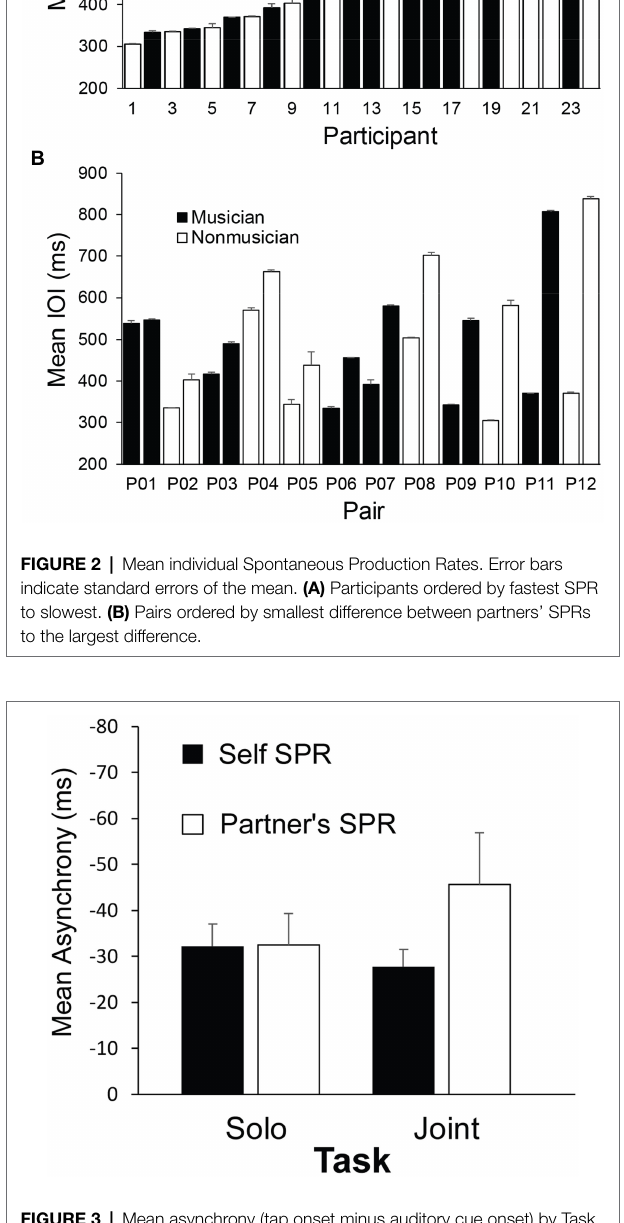
FIGURE 3 | Mean asynchrony (tap onset minus auditory cue onset) by Task and Cued Rate. Error bars indicate standard error of the